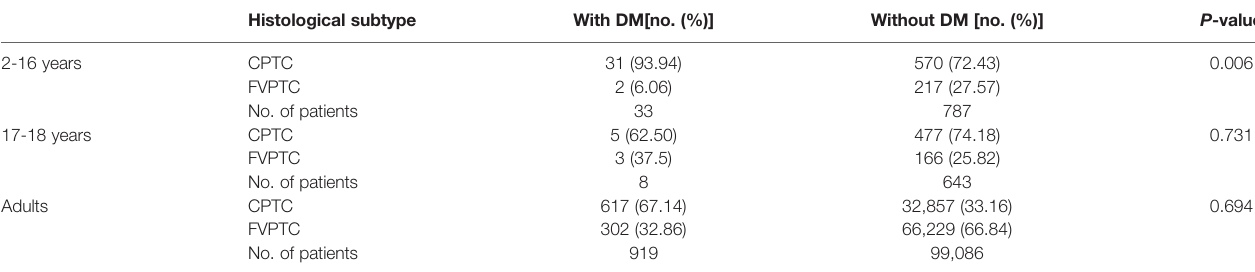
TABLE 4-2 | Comparison of histological subtype in different age groups with distant metastasis of PTC. Histological subtype